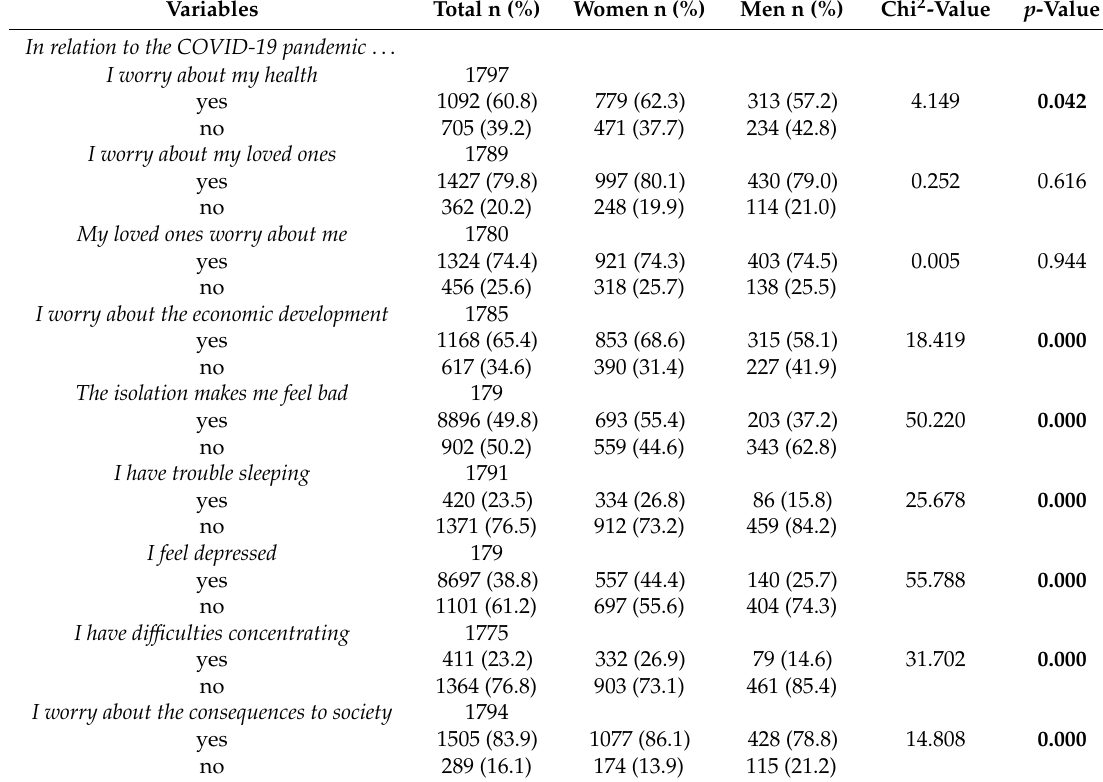
Table 4. Reported mental health based on gender (number, percentage and Chi 2